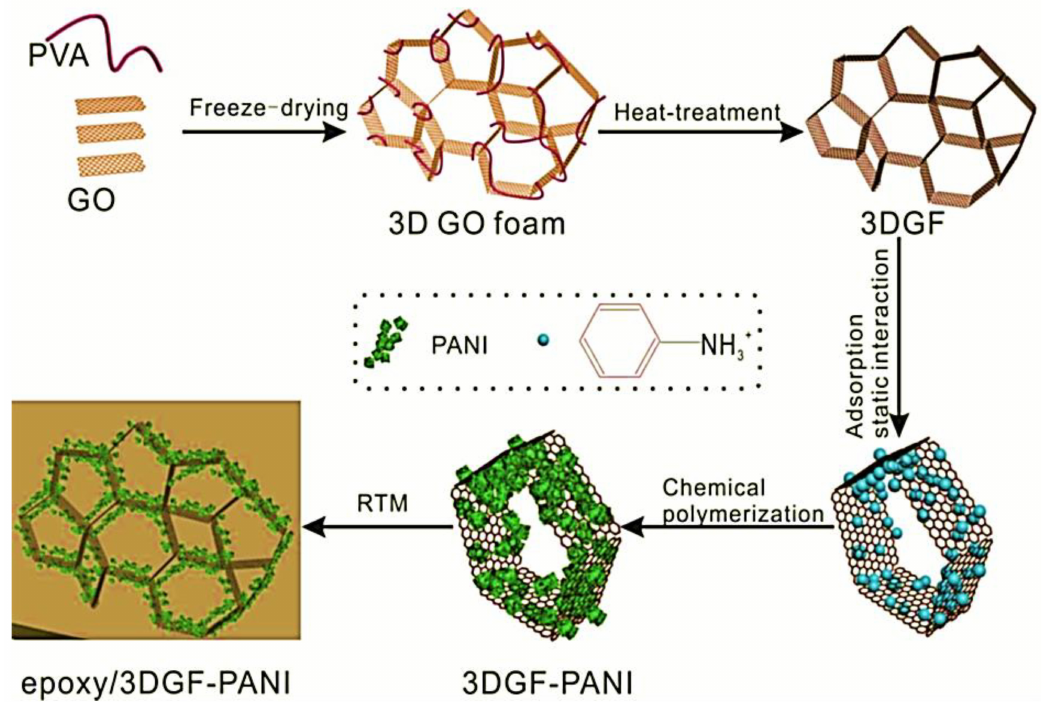
Figure 4. Schematic of preparation of three dimensional graphene oxide-polyaniline (3DGF-PANI) and epoxy/three dimensional graphene oxide-polyaniline (epoxy/3DGF-PANI) nanocomposite. Reprinted with permission from Ref. [77]. 2018, Elsevier.